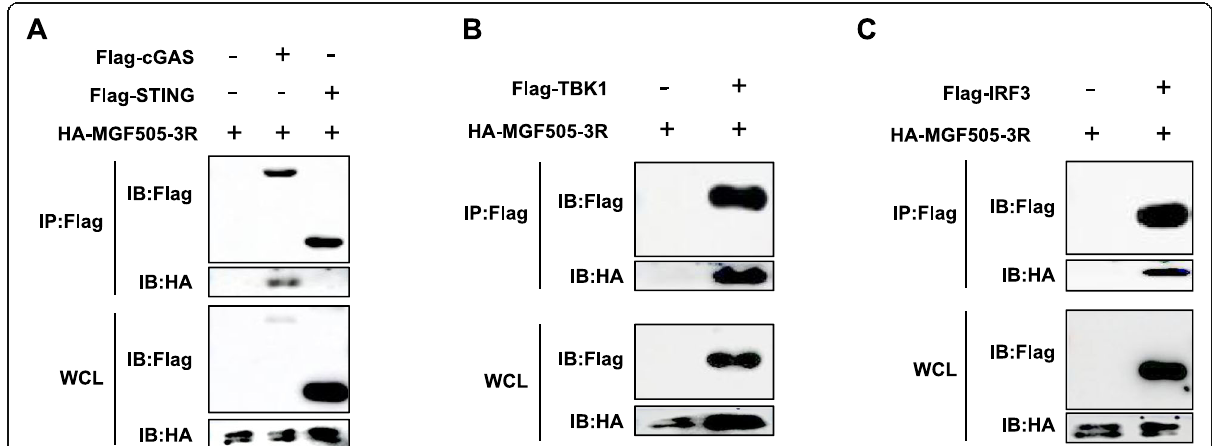
Fig. 4 MGF505-3R interacts with cGAS, TBK1 and IRF3 in the cGAS-STING pathway. A-C HEK293T cells were cotransfected with HA-MGF505-3R expression plasmid (1 μ g) and Flag-tagged molecular expression plasmids (cGAS, STING, TBK1, IRF3) (1 μ g) for 24 h. “ + ” represents transfected, “ - ” represents nontransfected. For Co-IP experiments, western blotting analysis was performed with the indicated antibodies to evaluate whole cell lysates (WCLs) and immunoprecipitated